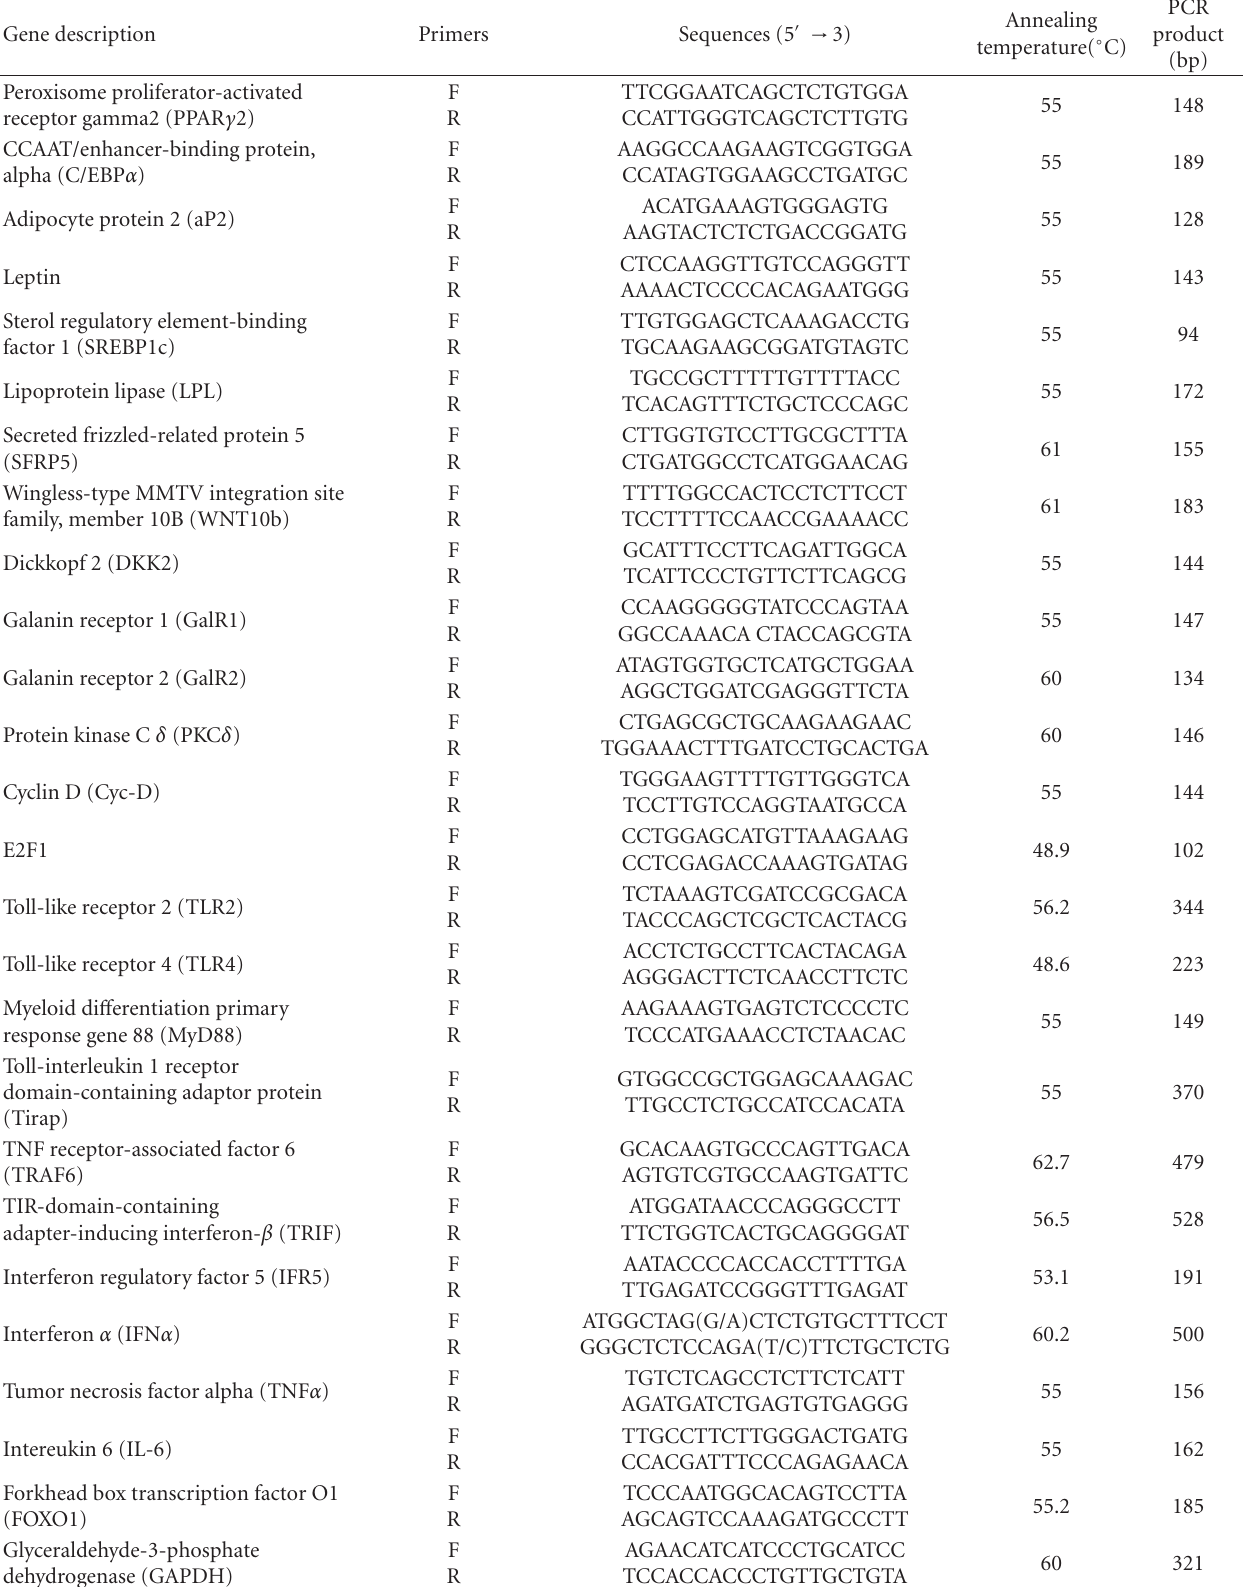
Table 1: Primer sequences and PCR